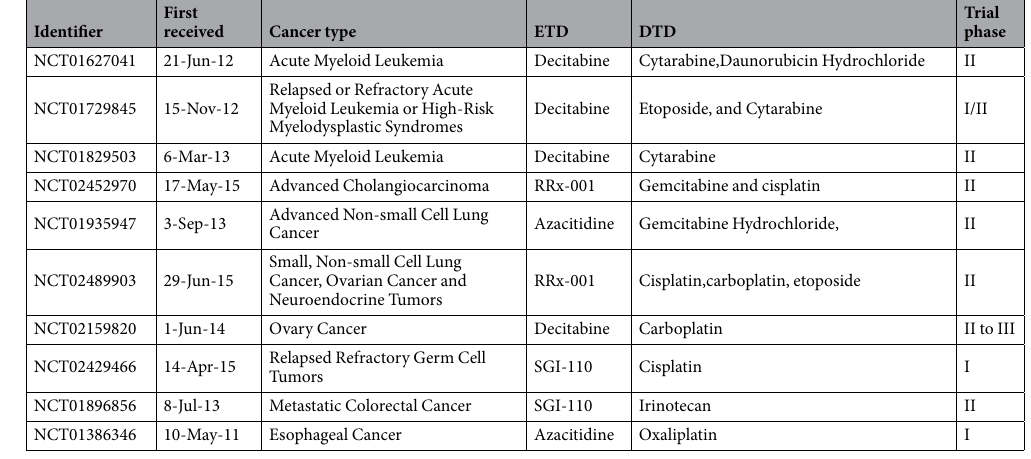
Table 3. On-going clinical trials of ETD plus